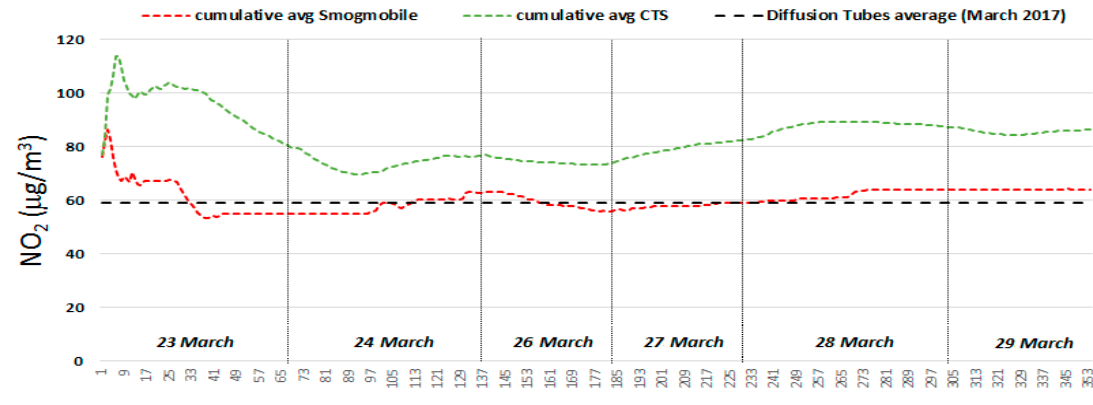
Figure 9. Cumulative average CMS (5-days), Smogmobile (excluding car park monitoring data, 5-day data) and Diffusion Tube (Monthly) NO 2 concentrations, µg/m 3 (Survey Period, March 2017).